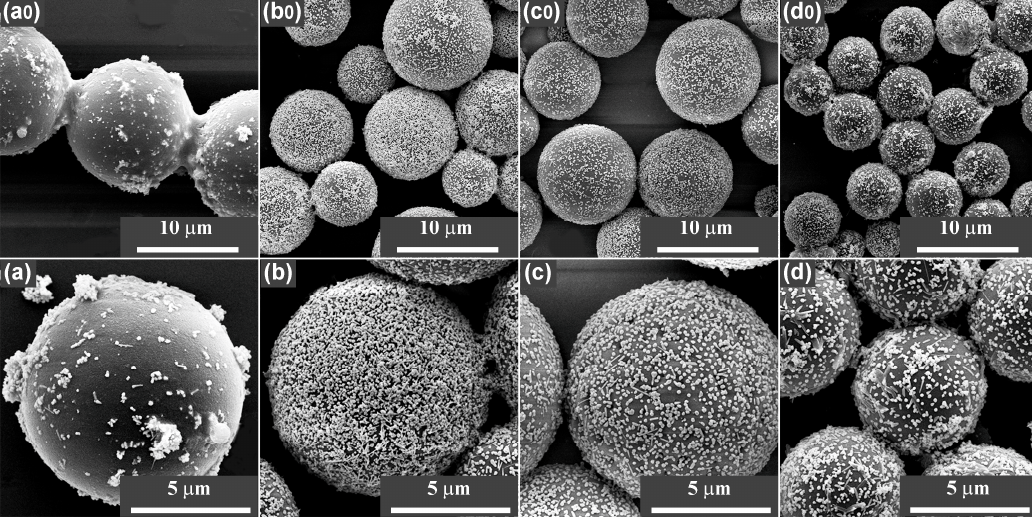
Figure 6. SEM images of AgNPs on MFMSs synthesized with a set of F:M molar ratios in 3 h. ( a , a0 ) MF 1 ; ( b , b0 ) MF 3 ; ( c , c0 ) MF 7 ; and ( d , d0 ) MF 9 . In the case of AgNP/MF 1 MSs ( a , a0 ), the AgNPs